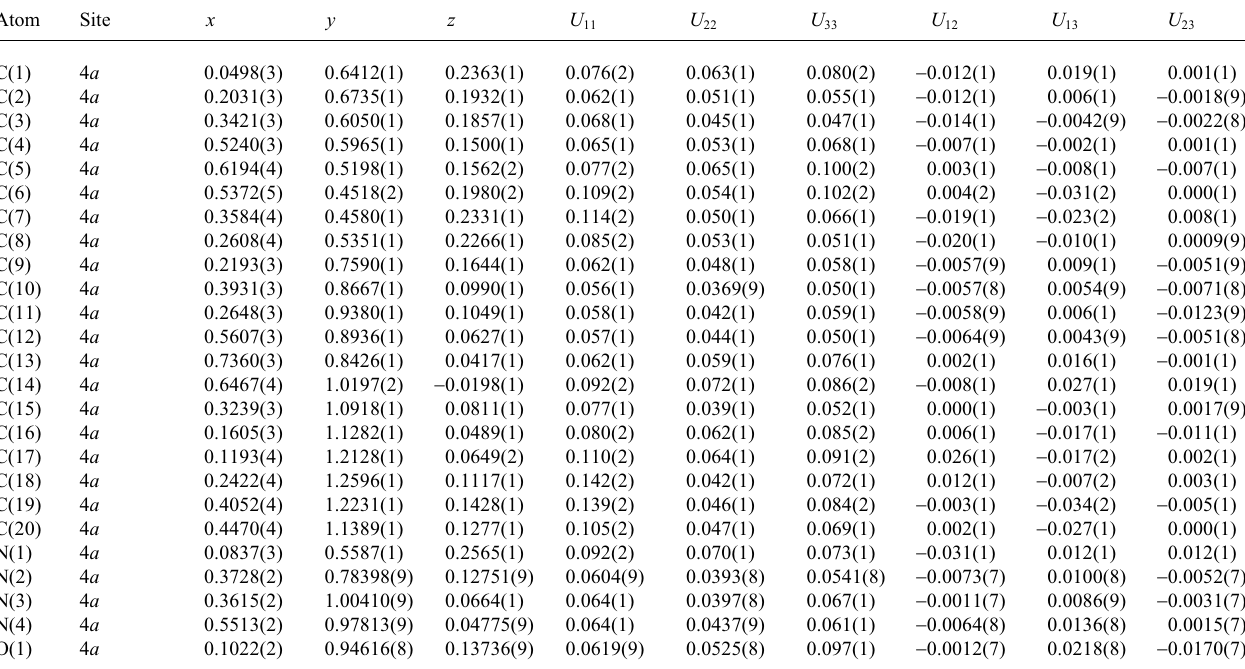
Table 3. Atomic coordinates and displacement parameters (in Å 2 )